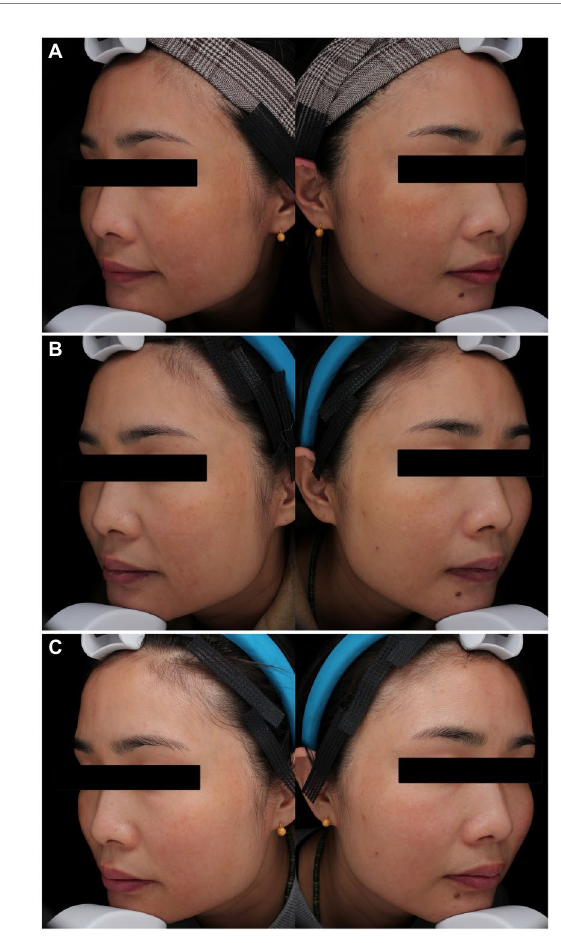
FIGURE 4 Melasma in a 41-year-old woman with Fitzpatrick skin type IV in the PSNYL (1,064 nm) group. (A) At baseline, MASI score = 18.6; (B) one month after three laser treatments (week 12), MASI score = 13.1; (C) four months after three laser treatments (week 24), MASI score = 11.7. PSNYL, picosecond Nd:YAG laser.